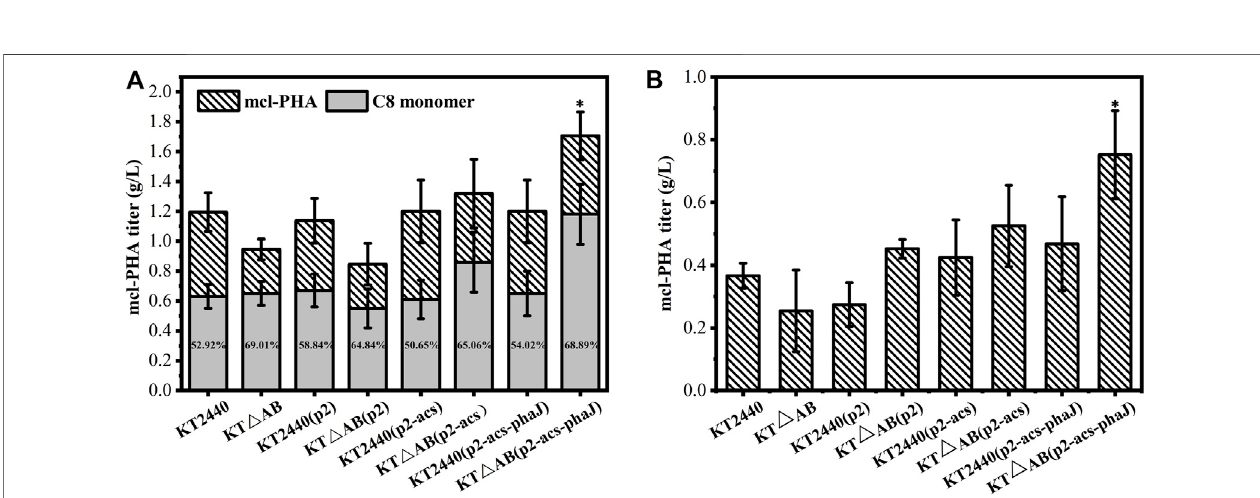
FIGURE 5 | P. putida KT2440 (A) and the engineered strain P. putida KT Δ AB (p2-acs-phaJ) (B) were used to produce mcl-PHA from acetic acid as the sole substrate in a bioreactor through fed-batch strategy. The error bars indicate the standard deviation of triplicate experiments.